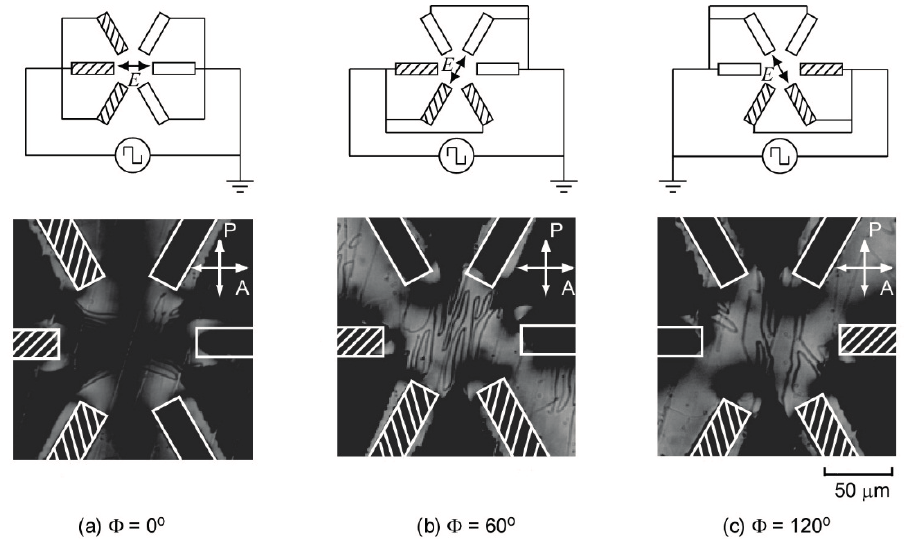
Figure 2. Polarization microscopic images of the NLC defect layer upon applied electric field for ( a ) Φ = 0°, ( b ) Φ = 60°, and ( c ) Φ = 120°. Illustrated circuits were used to apply a voltage to the six